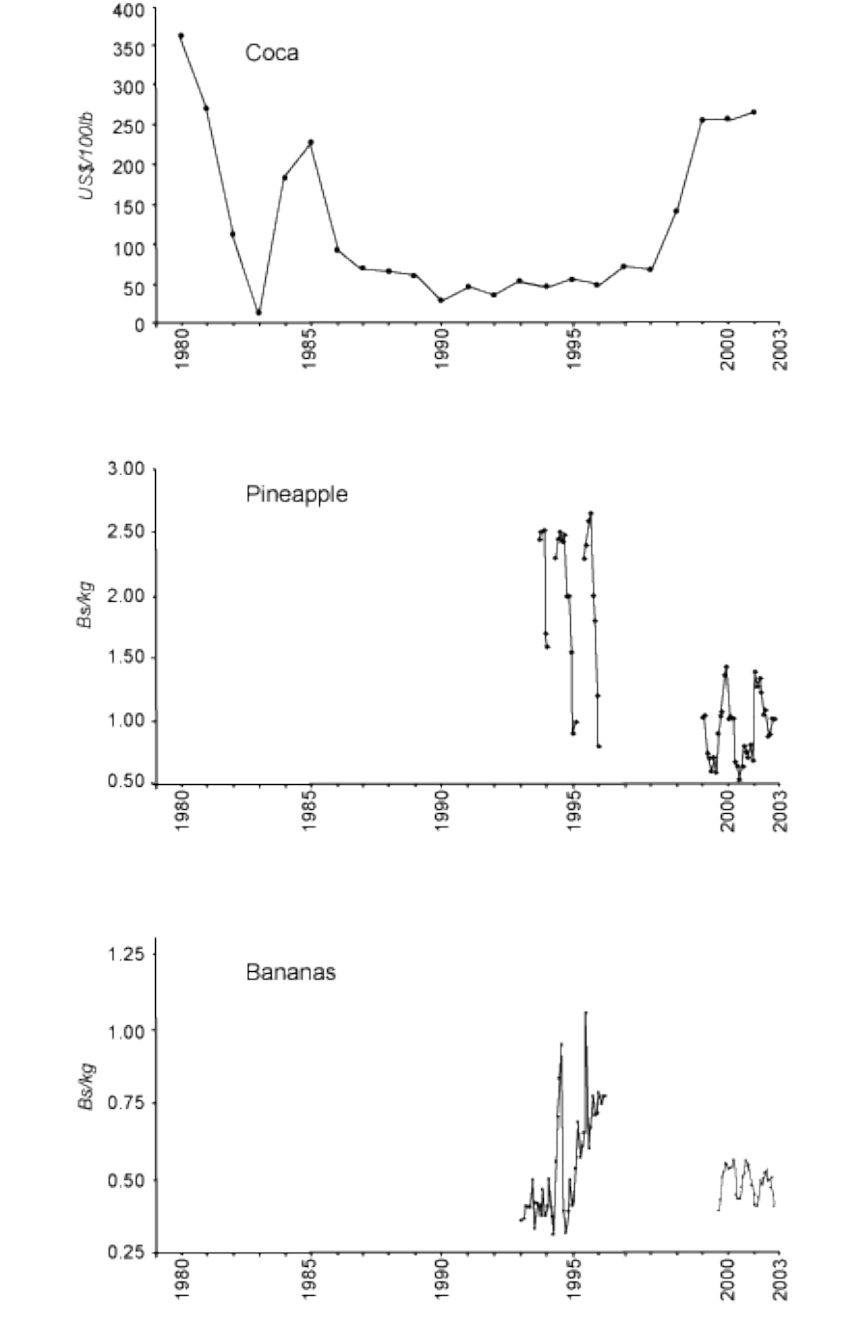
Fig. 5. Price data for coca leaves (top), pineapple (middle), and bananas (bottom) traded in Chapare. Data are from different sources, refer to text for